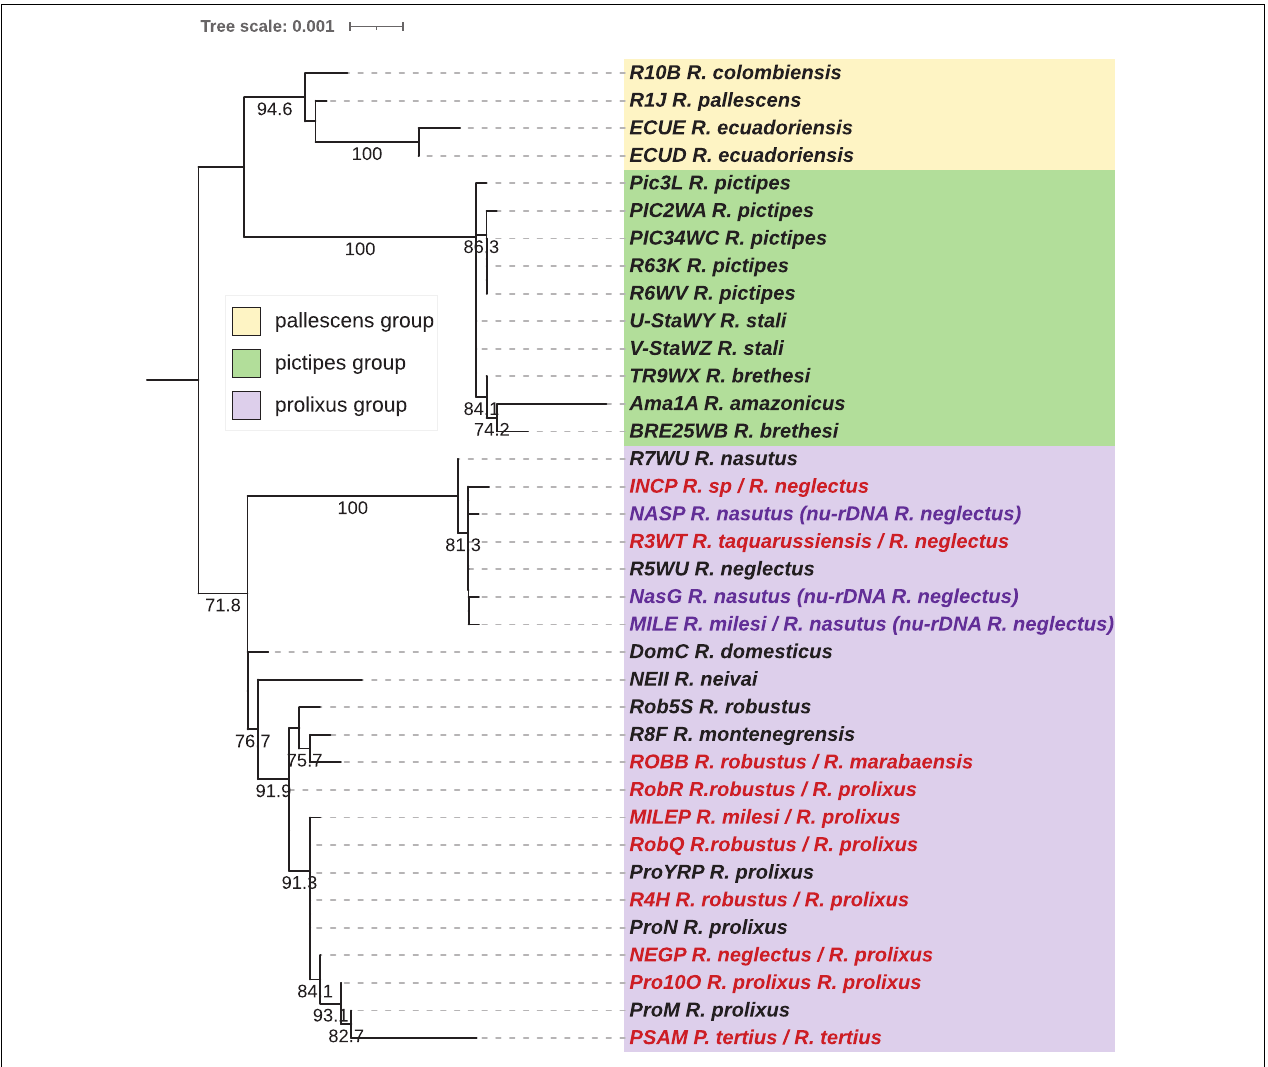
FIGURE 3 | Phylogenetic inferences for the concatenated nuclear rDNA (nu-rDNA) dataset for Rhodnius species with the Maximum Likelihood (ML) method. Statistical supports (1,000 replicates SH-aLRT) are indicated on the nodes. B. colossus was used as outgroup. Introgressed species inferred from the nuclear phylogeny (see Figure 5 ) are indicated in purple, and misidentified species in